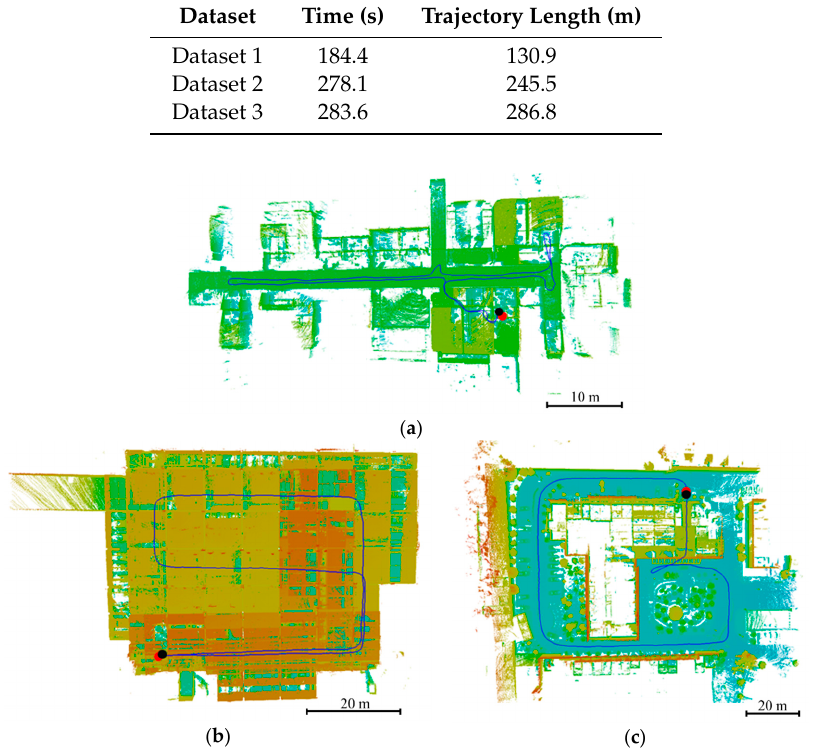
Figure 8. The SLAM device trajectory. The blue line in ( a – c ) are the trajectories in datasets 1–3 respectively. The red dot and black dot in the figure represent the start and end of trajectory respectively.